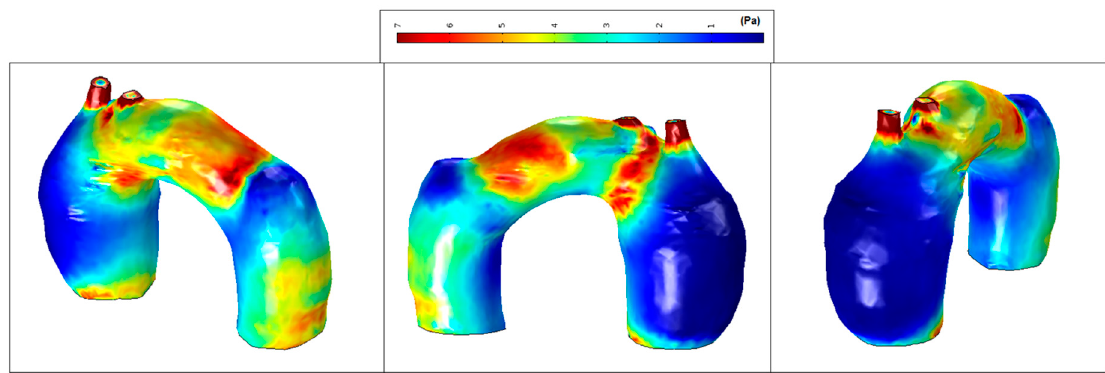
Figure 15. Patient 1: wall shear stress (WSS) contours (at peak systole).